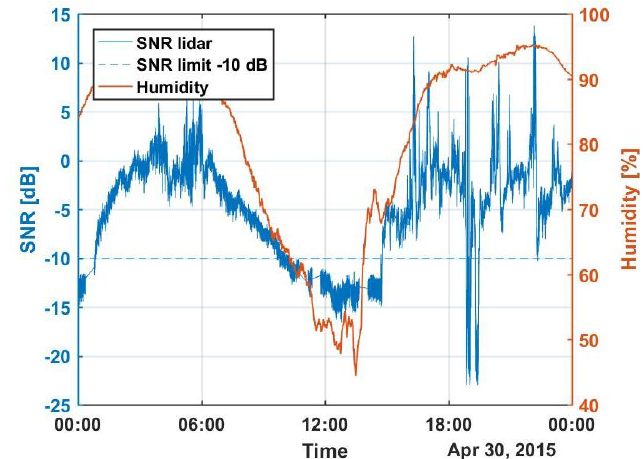
Figure 7. Temperature, relative humidity and SNR versus time for a 24 h period on 30 April 2015. The optimal SNR limit of − 10 dB is included as a reference. Times are local